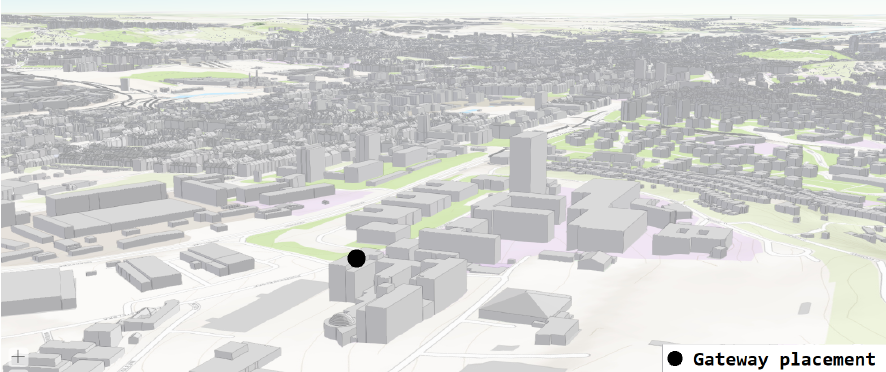
Figure 4. Location of our private one-gateway LoRaWAN experimental network with view of the city of Brno (website: http://webmaps.kambrno.cz/ (accessed on 15 February